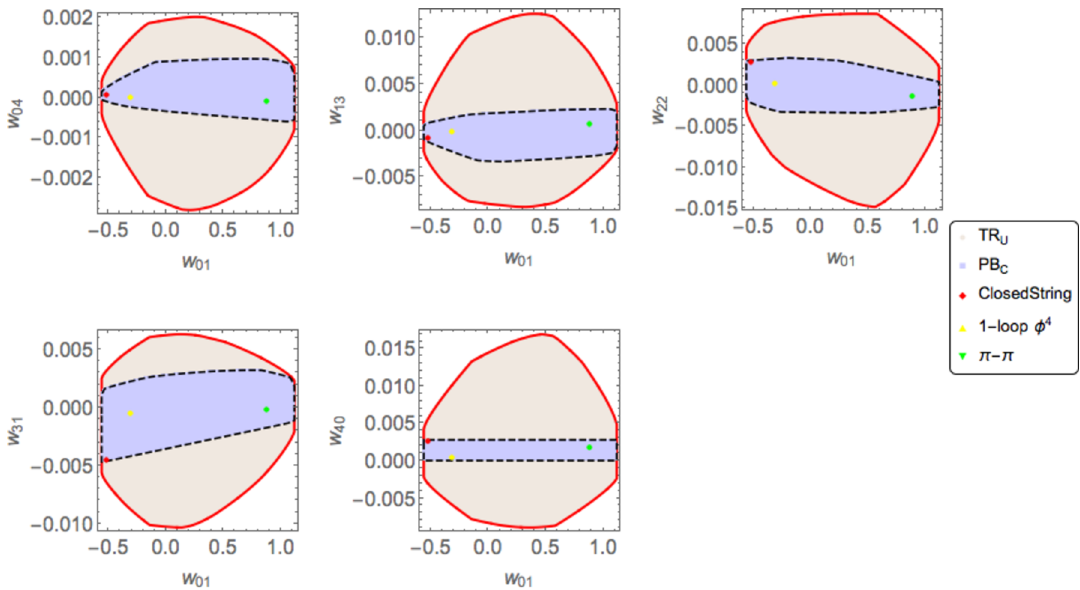
Figure 15. The comparison of the regions obtained for w 04 , w 13 , w 22 w 31 and w 40 with w 01 .